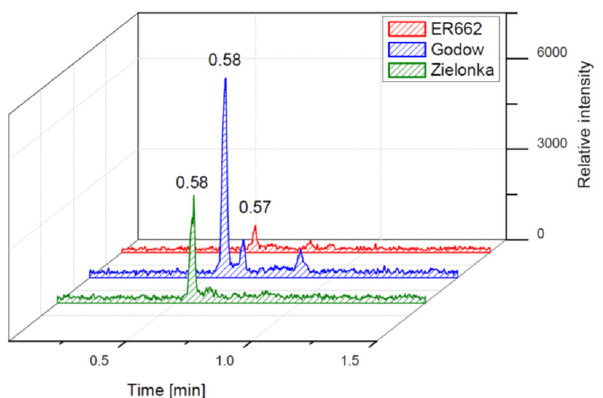
Figure 9. Extracted-ion chromatograms of 2-methyltartaric acid organosulfate with MW 244 from field studies and chamber exper- iments (not detected in non-acidic sample).